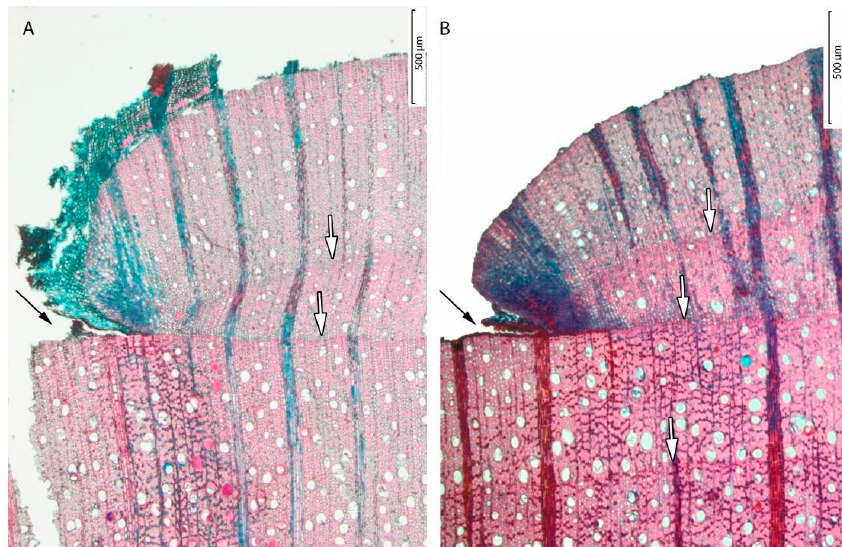
Figure 4. Microphotograph of the wound tissue formed in response to the cambial pinning. The cambial mark is indicated with black arrows in ( A ) sample Tw64884 and ( B ) sample Tw64881. The trees were marked on March 15 2012 and sampled after 498 days on July 25 2013. The tree-ring boundaries are indicated with white arrows.